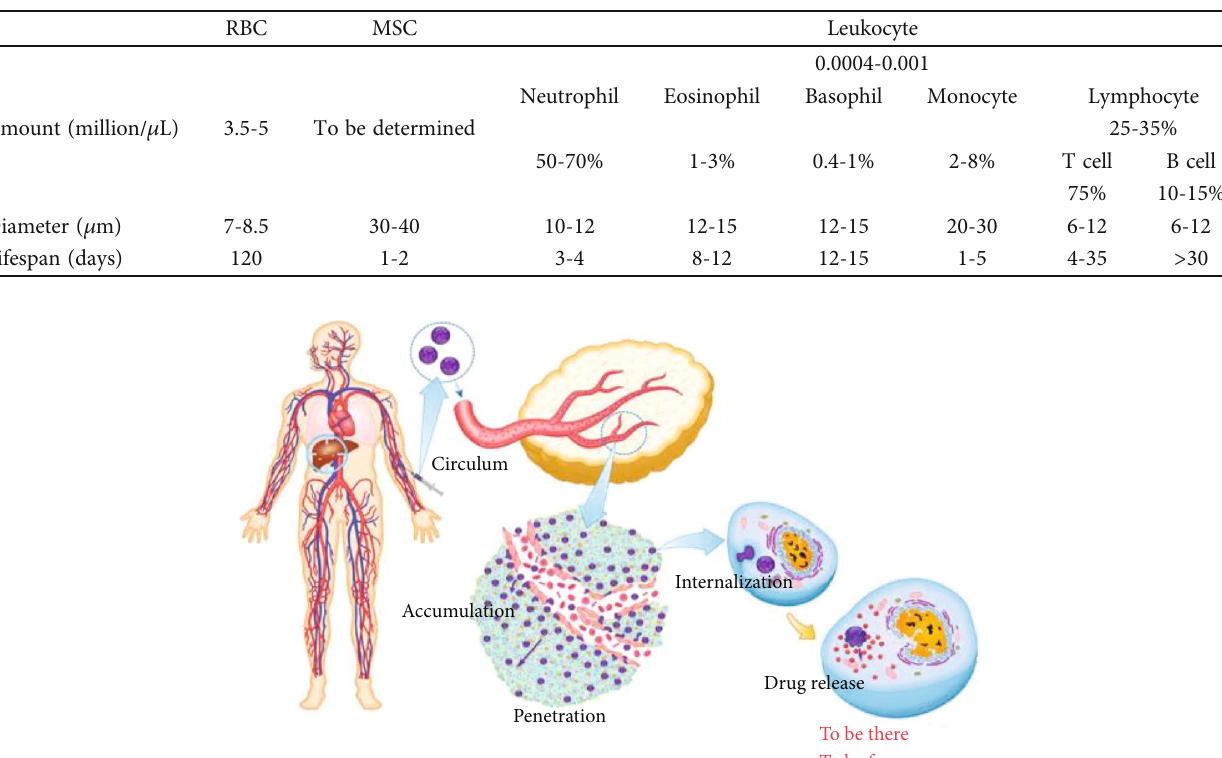
Table 1: Properties of red blood cells, mesenchymal stem cells, and leukocytes.